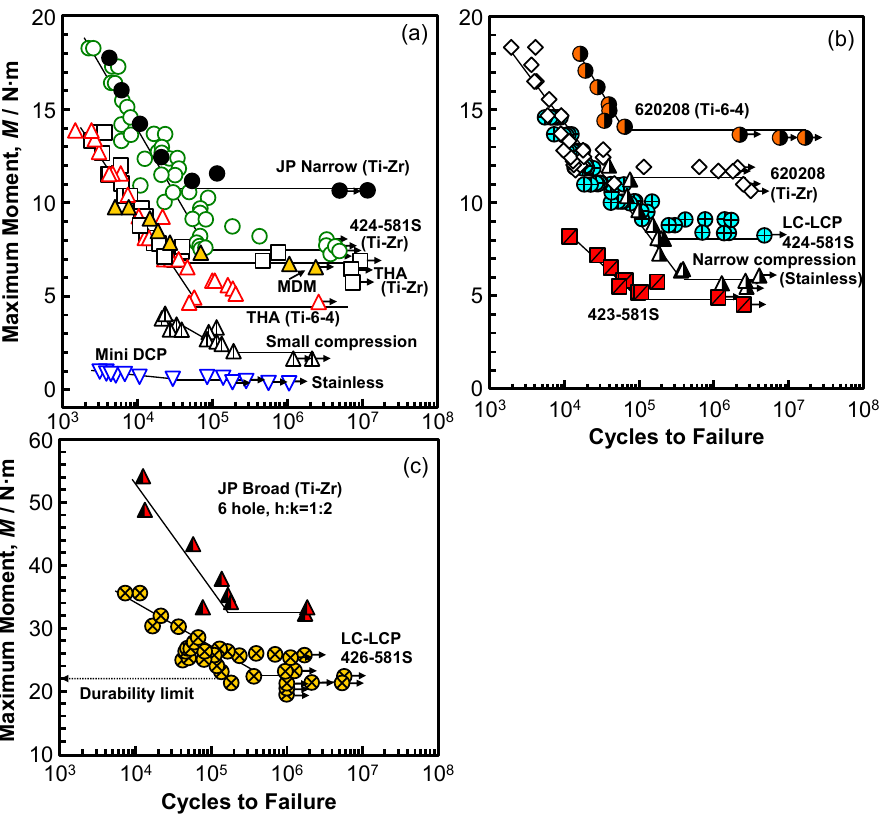
Figure 5. M–N curves of various bone plates obtained by four-point bending durability tests. ( a ) Relative small loaded bone plates; ( b , c ) relative large loaded bone plates.